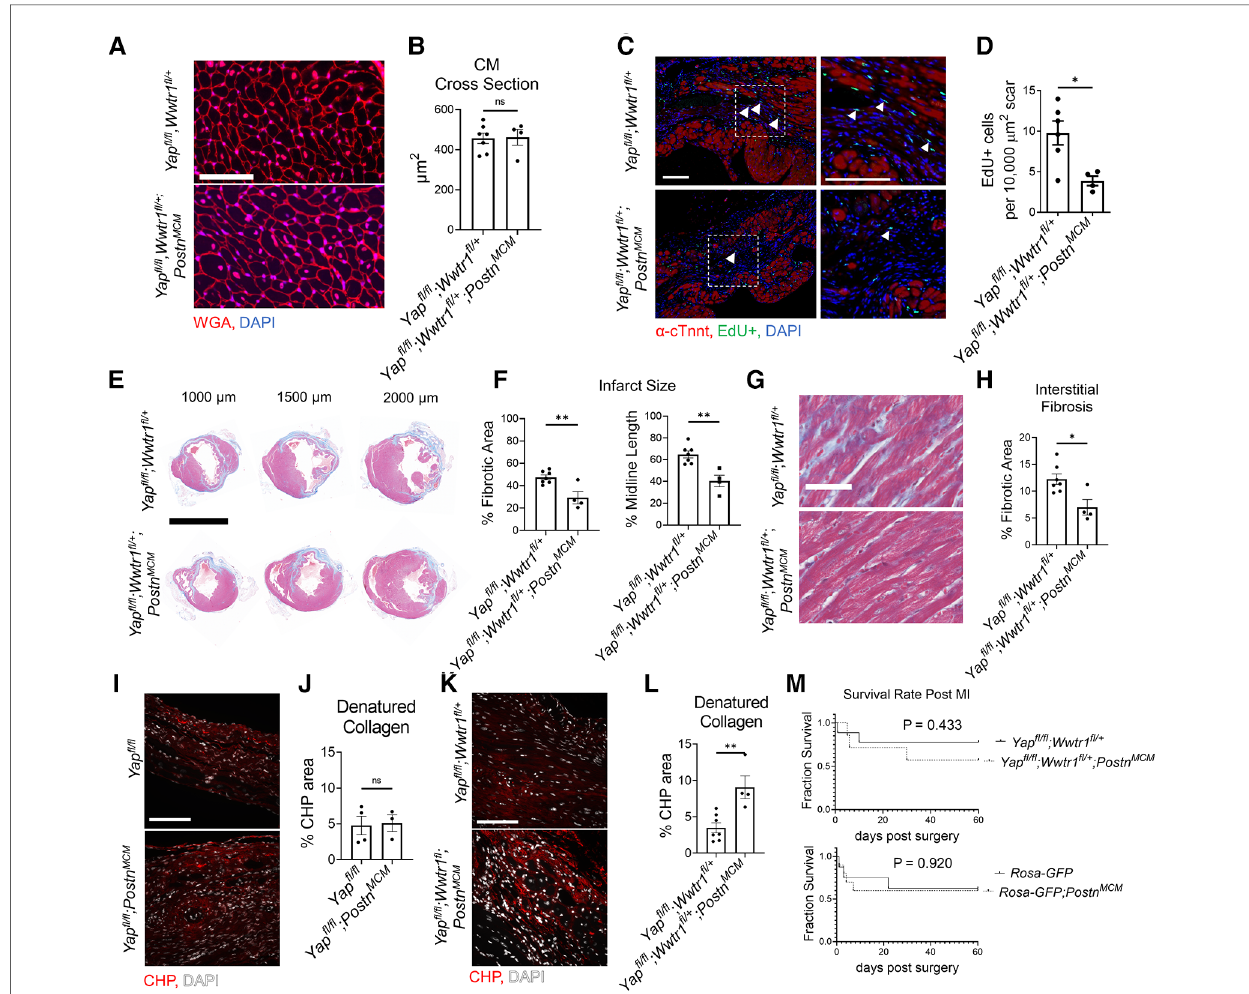
FIGURE 3 Depletion of myo fi broblast Yap and Wwtr1 decreases fi brosis at 60 dpi. ( A ) Representative images of WGA staining in the remote zone of the left ventricle at 60 dpi. Scale=50 µm. ( B ) Quanti fi cation of cardiomyocyte cross sectional area. n =7 Yap fl / fl ;Wwtr1 fl /+ and 4 Yap fl / fl ;Wwtr1 fl /+ ;Postn MCM . Unpaired student ’ s t -test. ( C ) Representative images denoting EdU+ nuclei within the scar area. White arrows indicate EdU+ scar associated nuclei. Scale= 100 µm. ( D ) Quanti fi cation of EdU+ scar associated nuclei. n =6 Yap fl / fl ;Wwtr1 fl /+ and 4 Yap fl / fl ;Wwtr1 fl /+ ;Postn MCM . Unpaired student ’ s t -test. ( E ) Representative serial sections of Gömöri trichrome stained hearts measured from the apex. Scale=5 mm. ( F ) Quanti fi cation of infarct scar size by either total fi brotic area or midline size of the left ventricle. n =7 Yap fl / fl ;Wwtr1 fl /+ and 4 Yap fl / fl ;Wwtr1 fl /+ ;Postn MCM . Unpaired student ’ s t -test. ( G ) Representative images depicting interstitial fi brosis within the remote zone of Gömöri trichrome stained hearts. Scale=50 µm. ( H ) Quanti fi cation of the % blue fi brotic area vs. total ventricular tissue. n =7 Yap fl / fl ;Wwtr1 fl /+ and 4 Yap fl / fl ;Wwtr1 fl /+ ;Postn MCM . Unpaired student ’ s t -test. ( I,K ) Representative images of CHP staining within the scar region of 60 dpi mice. Scale=100 µm. ( J,L ) Quanti fi cation of CHP as a % area of the scar region. n =4 Yap fl / fl , 3 Yap fl / fl ;Postn MCM , 7 Yap fl / fl ;Wwtr1 fl /+ , and 4 Yap fl / fl ;Wwtr1 fl /+ ;Postn MCM . Unpaired student ’ s t -test. ( M ) Survival curve comparing Yap fl / fl ;Wwtr1 fl /+ and Yap fl / fl ;Wwtr1 fl /+ ;Postn MCM or R26-eGFP f/+ and R26-eGFP f/+ ; Postn MCM mice after MI until the 60 dpi end point. Animals that died during surgery were not included. n =9 Yap fl / fl ;Wwtr1 fl /+ , 7 Yap fl / fl ;Wwtr1 fl /+ ;Postn MCM , 8 R26-eGFP f/+ , 10 R26-eGFP f/+ ;Postn MCM . Logrank Mantel-Cox test. Ns, not signi fi cant, * P <0.05, and ** P